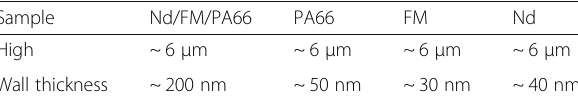
Table 1 Size parameters, length, and (wall) thickness of nanostructure